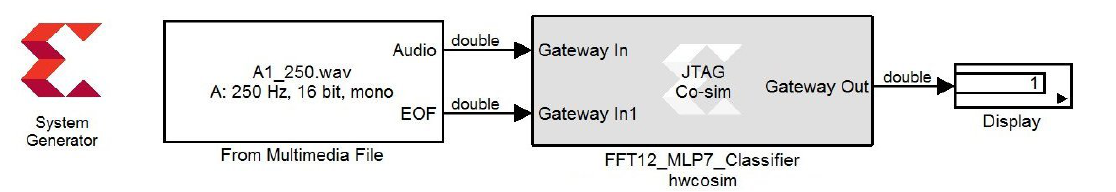
Figure 15. Simulink diagram of the hardware/software cosimulation.